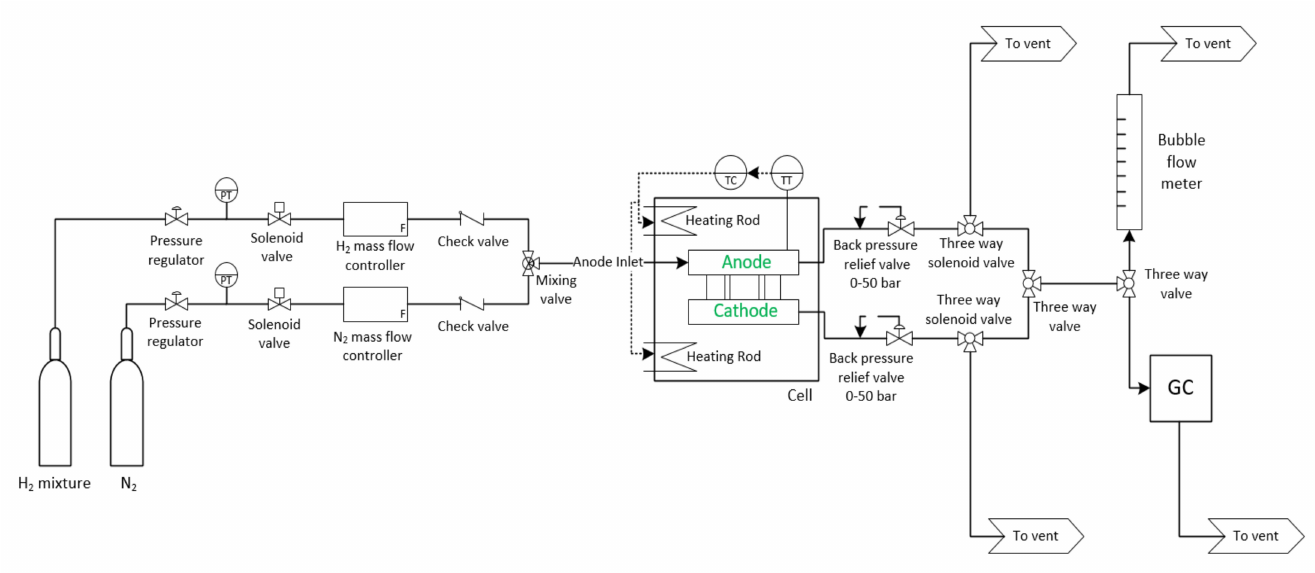
Figure 3. Experimental set-up used for electrochemical hydrogen